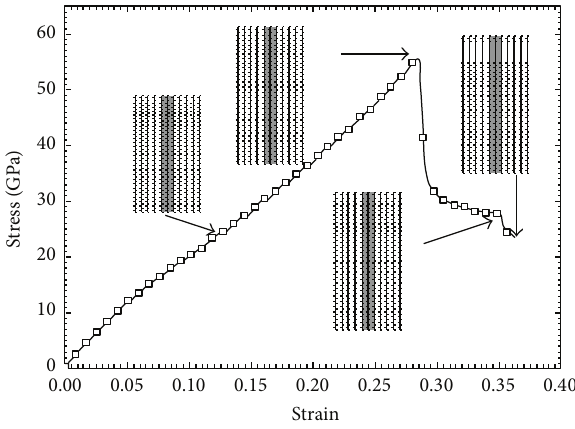
Figure 11: Tensile deformation and failure of CNT/PE composite.